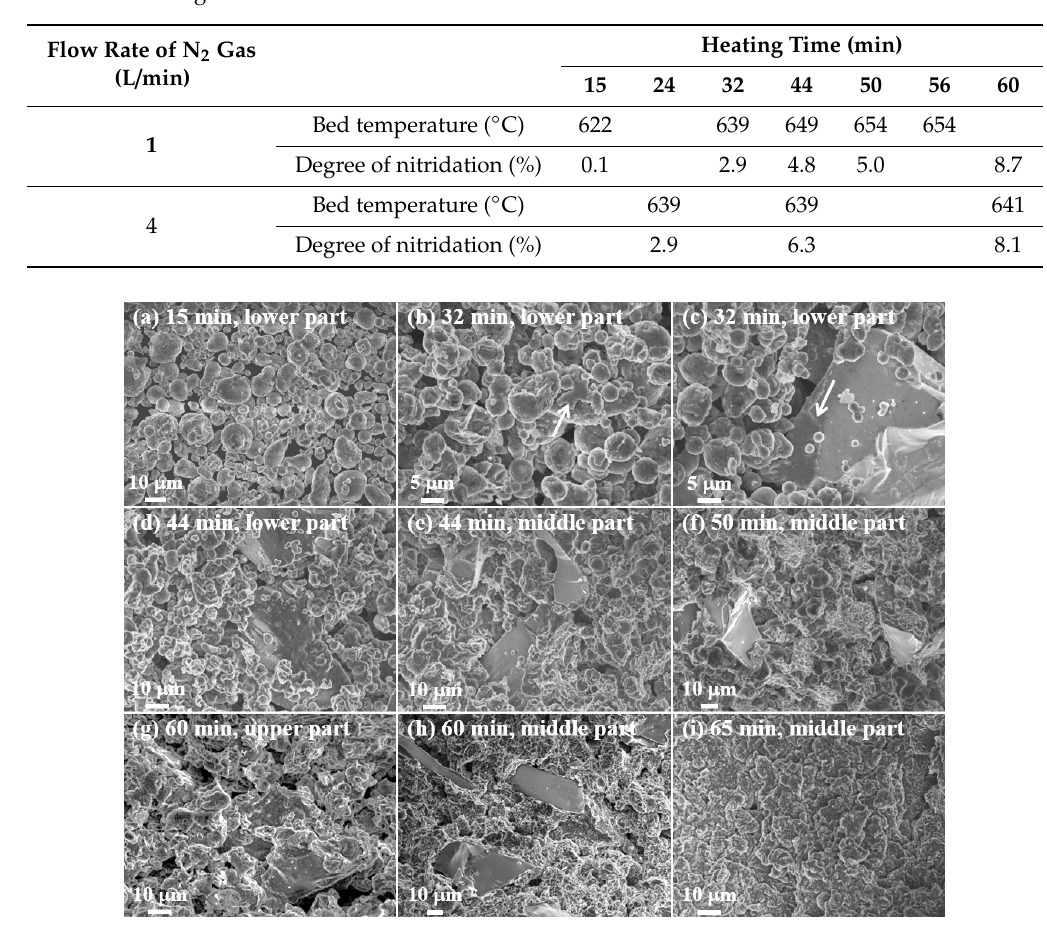
Table 1. The degrees of nitridation and temperatures of the powder bed with various nitrogen flow rates and heating times.